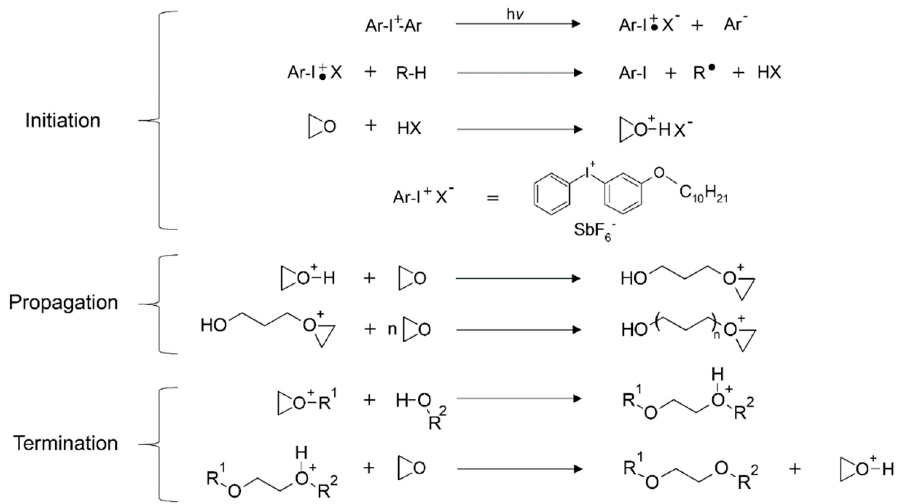
Figure 20. Mechanism of photoacid-initiated epoxy polymerization (cationic chain-growth). Repro- duced with permission from [219], Copyright © 2022 John Wiley and Sons.